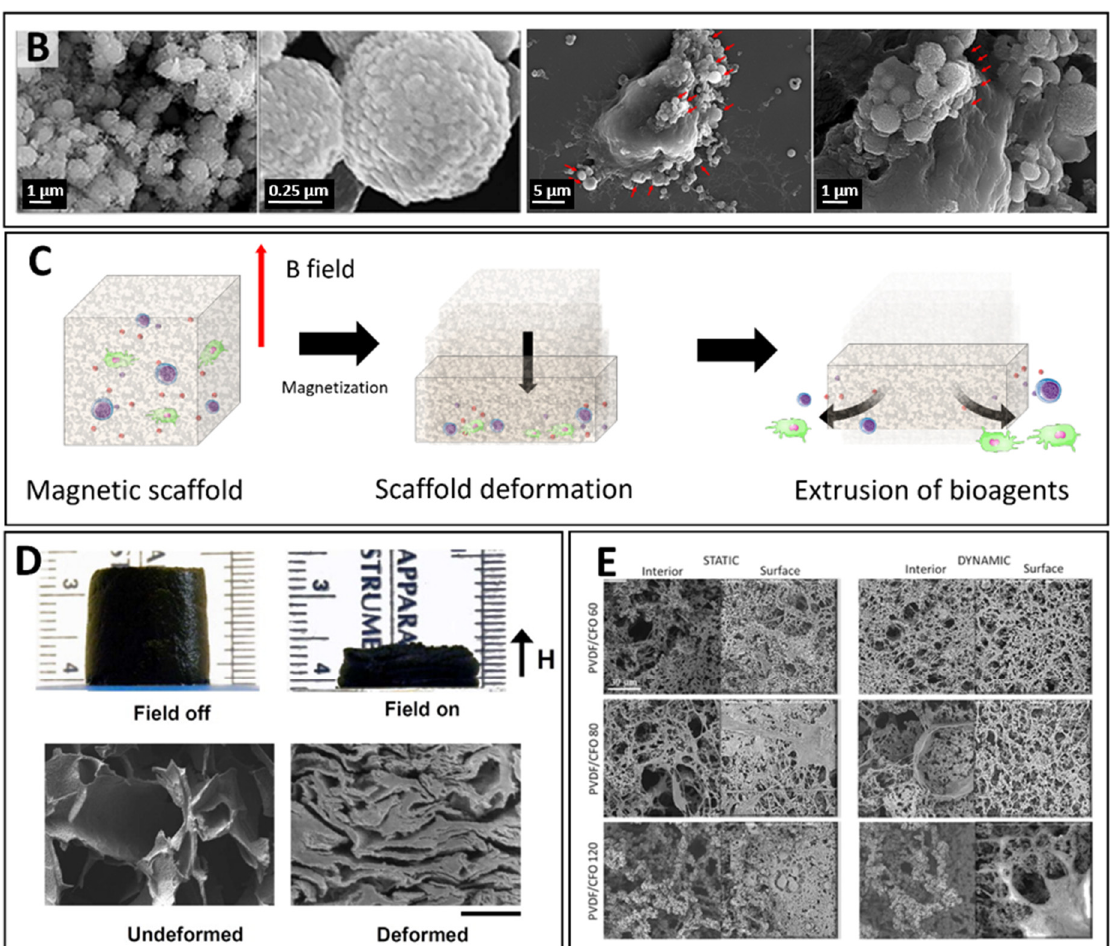
Figure 6. MCs for drug delivery as injectable agents or magnetizing agents for scaffolds. ( A ) Drug delivery via injectable MNPs: Shen et al. synthesized MNPs loaded with DOX and verapamil and coated with PLGA. Soon after the injection the mice were treated with a constant magnetic field (about 2000 Oe) laid outside the skin near the tumor site at 25 ◦ C for 3 h. Drug release was then obtained by NIR irradiation. Right: TEM (up) and SEM (bottom) images of the developed MNPs. Reproduced with permission from Ref. [201]. ( B ) SEM images of iron oxide mesoporous microparticles (left) and cells incubated with particles (right). Microparticles (indicated by red arrows) associated with breast cancer MCF7 cells, both as attached to the periphery, and internalized inside. Adapted and Reproduced with permission from Ref. [202] ( C ) Drug release from magnetized scaffold in response to macroscopic structural deformation. ( D ) A cylinder of a macroporous ferrogel reduced its height ∼ 70% when subjected to a vertical magnetic-field gradient of ∼ 38 A/m 2 , and SEM images of a freeze- dried sample in the undeformed and deformed states. (Scale bar: 500 µ m.) Adapted and Reproduced with permission from Ref. [203] ( E ) SEM images of a magnetized scaffold made of a piezoelectric polymer, poly(vinylidene fluoride) (PVDF), and magnetostrictive particles of CoFe 2 O 4 . Preosteoblast cells were cultured for four days on scaffolds with different pore sizes. When magnetically stimulated, cells grew around the pores, probably guided by the magnetomechanical and magnetoelectrical stimuli. Adapted and Reproduced with permission from Ref.